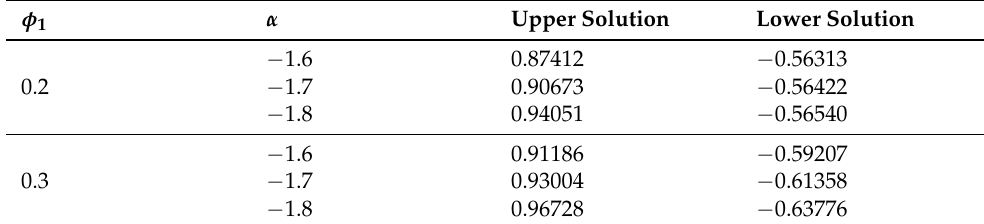
Table 4. Smallest eigenvalue numbers of γ against φ 1 .